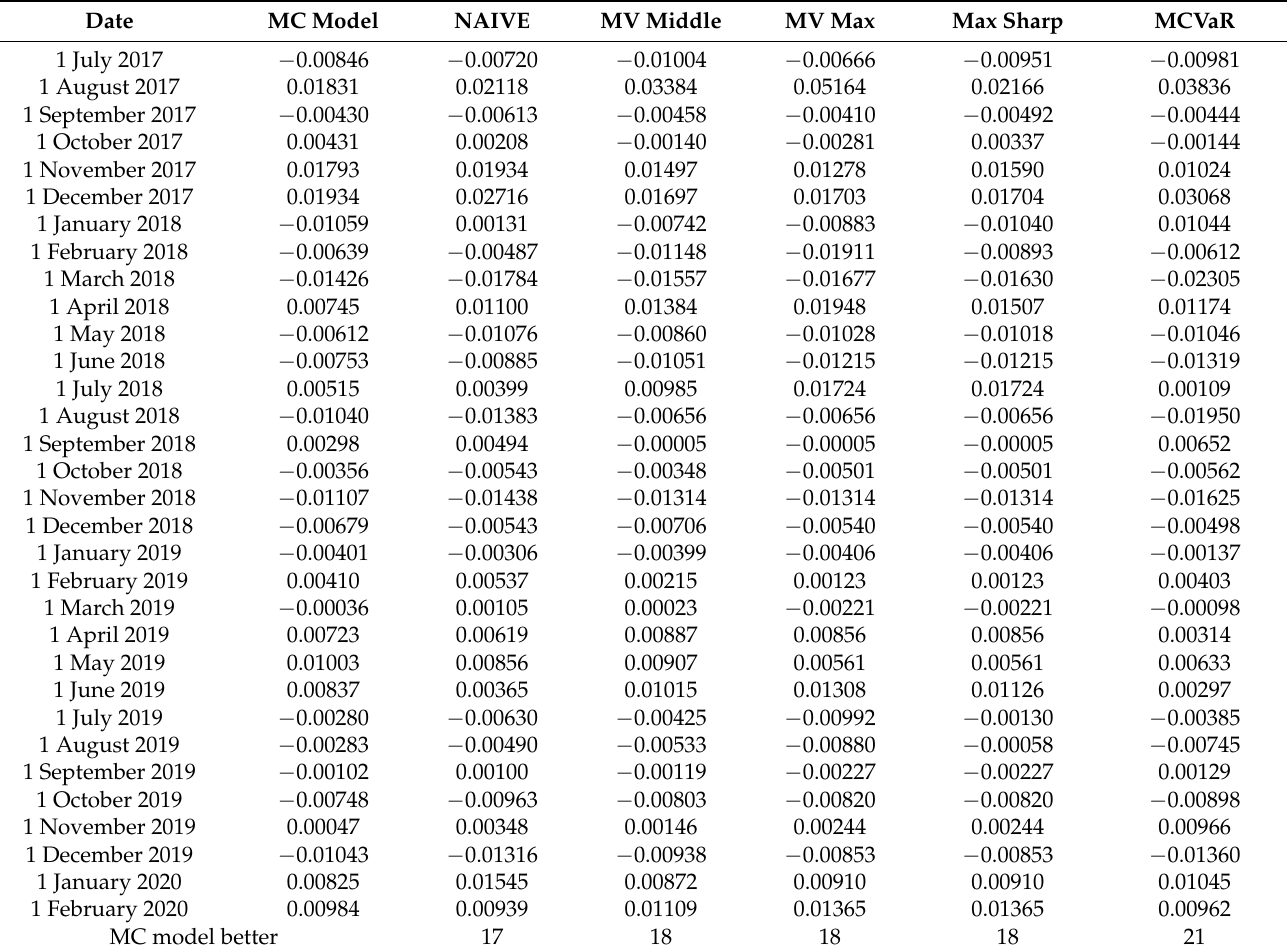
Table A1. Mean return in the next 30 days for 6 different